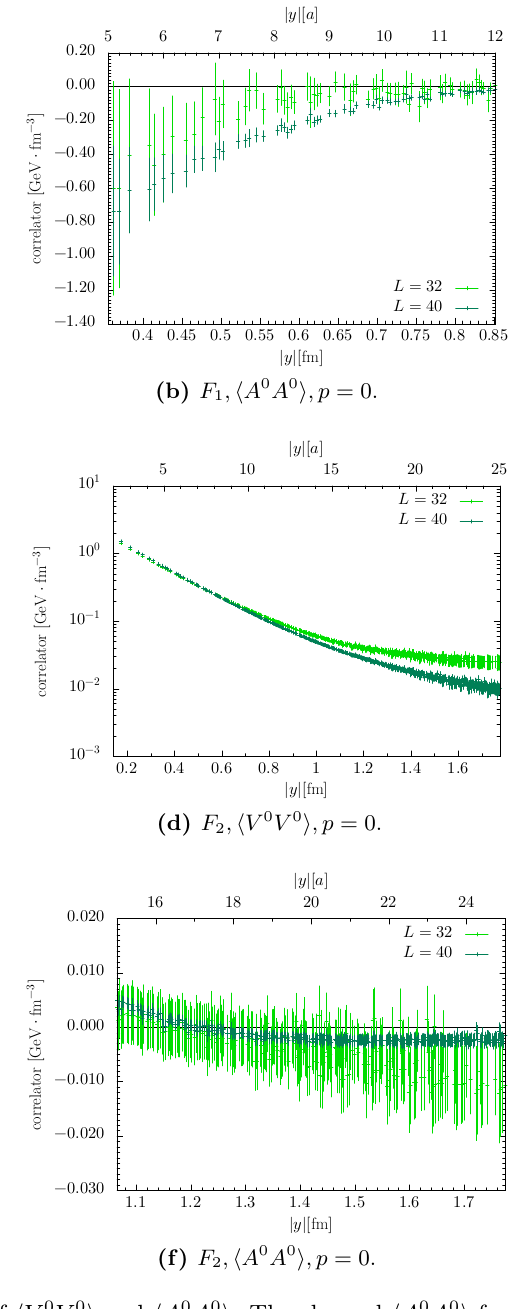
A 0 A 0 for h i